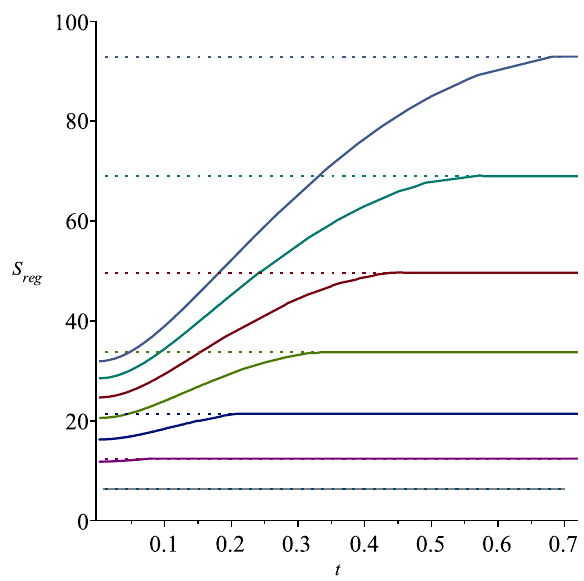
Figure 16 . Regulated entanglement entropy as a function of time for ~ T = 0 : 5 ; r H = 3 L AdS ; r max = 100. Plots from bottom to top show (cid:1) (cid:18) = 1 : 0 ; 1 : 2 ; 1 : 4 ; 1 : 6 ; 1 : 8 ; 2 : 0 ; 2 : 2.